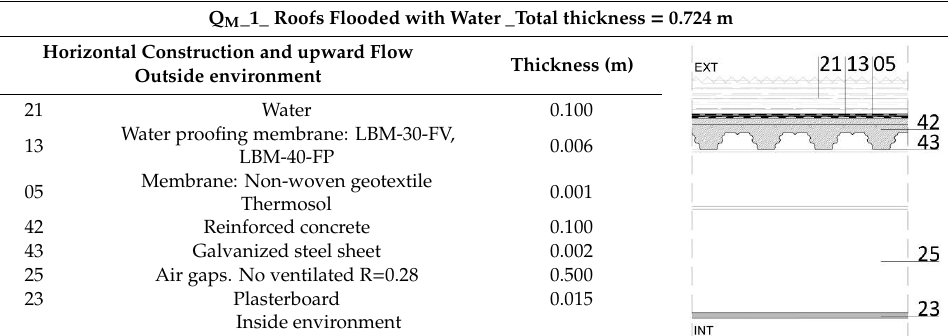
Table 2. Construction features of the roof of the MUA.